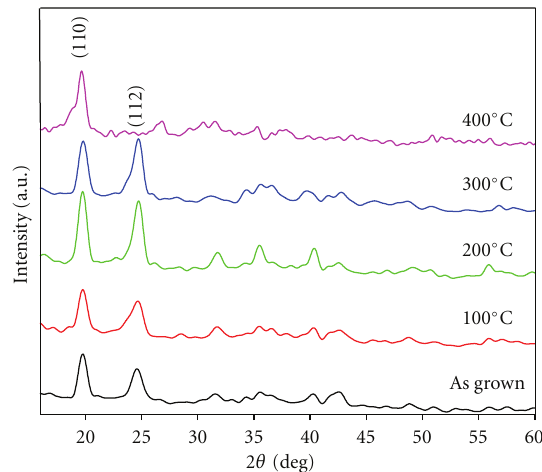
Figure 1: XRD pattern obtained from as grown and annealed, Ag doped nanostructured CdS thin films prepared by cost e ff ective chemical route at room